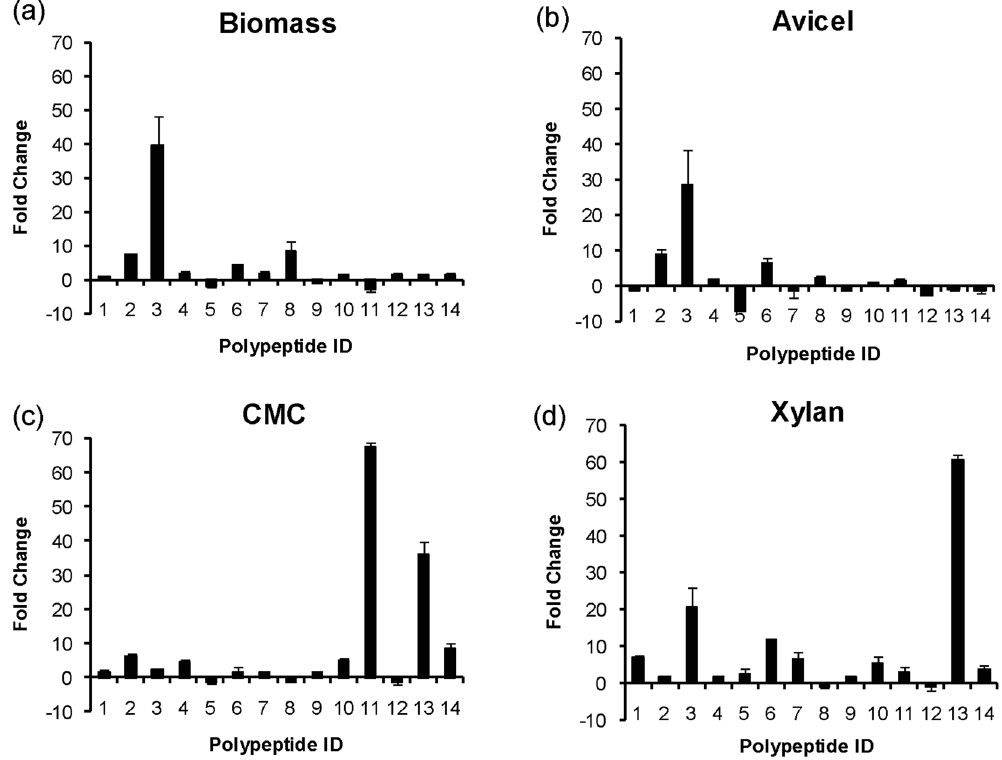
Figure 3. Relative transcript level of CBM containing polypeptides during growth on different carbon substrates. P . Polymyxa A18 was grown in presence of ( a ) ammonium hydroxide-treated biomass, ( b ) Avicel, ( c ) CMC and ( d ) xylan, and transcript levels of 14 CBM-containing polypeptides were estimated using qRT- PCR. Fold change was calculated with respect to P . Polymyxa A18 grown without the carbon substrate and normalized on 16S rRNA. Error bars represent standard error of mean calculated over four data obtained from two technical replicates of each of two biological